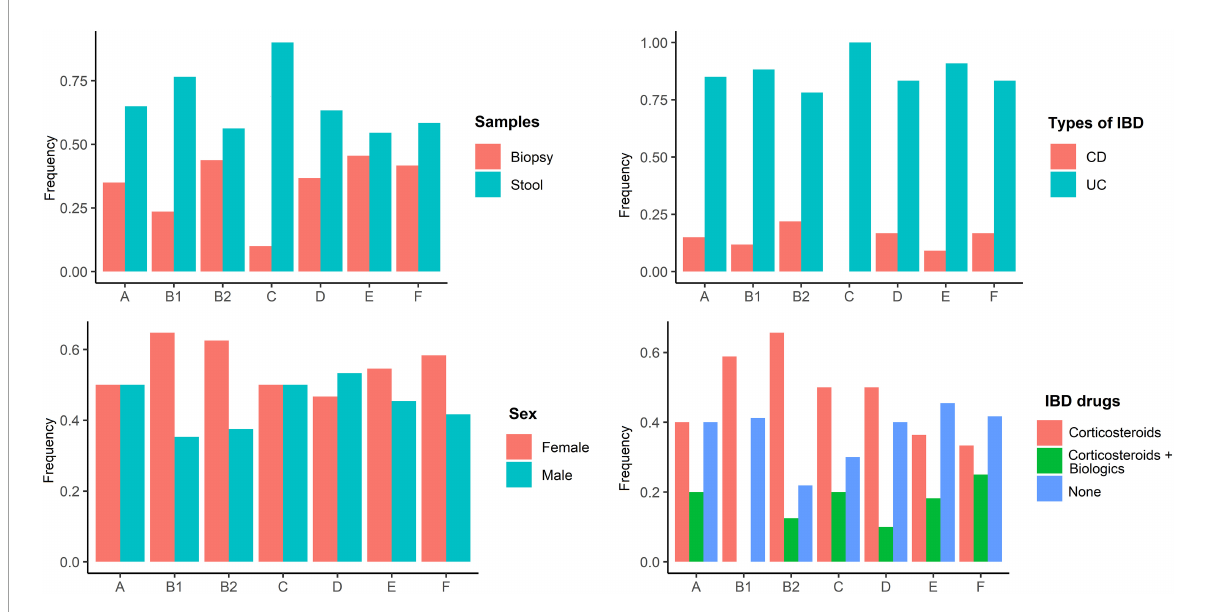
FIGURE3 Frequency of phylogenetic groups according to the gender of patients, type of samples, type of disease, and the used biologics and anti-inflammatory drugs.